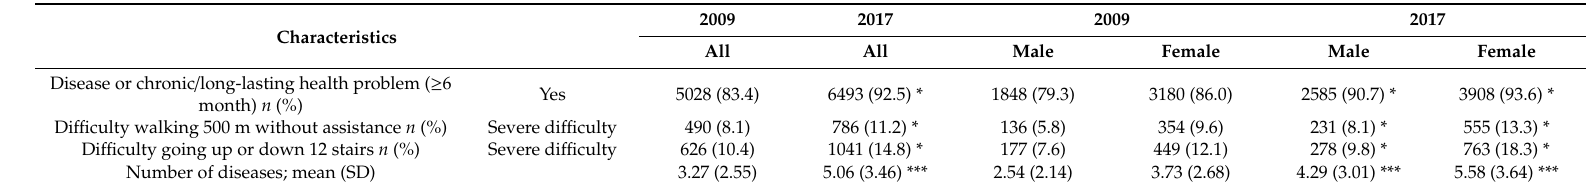
Table 2. Disease or chronic health problems and ability to walk regarding survey year and sex.